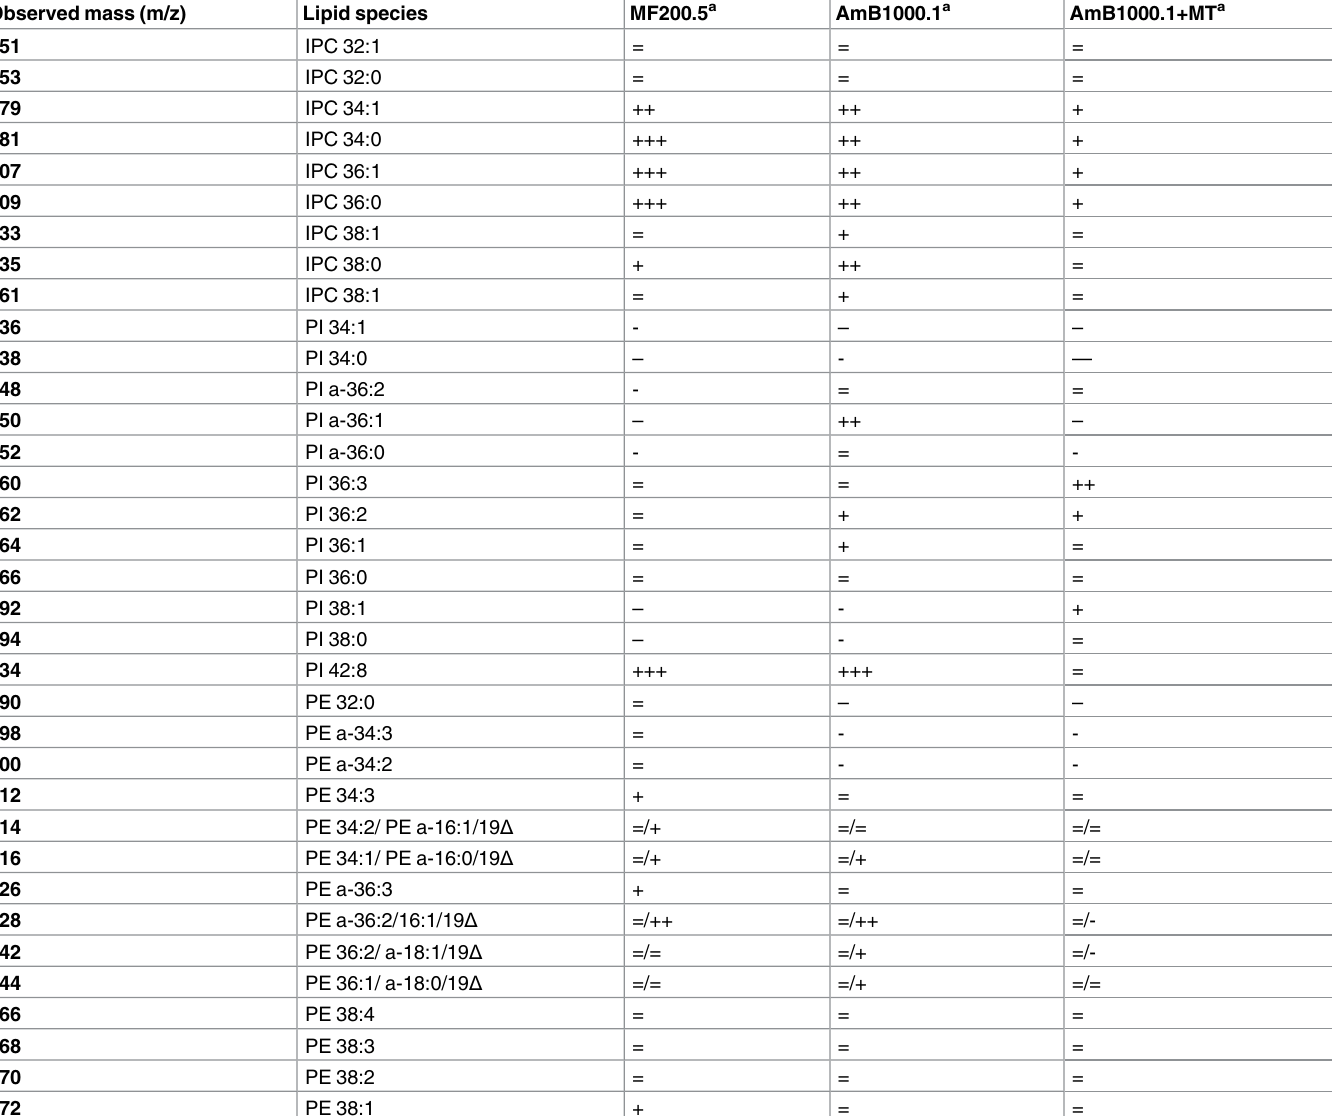
Table 1. Comparison of the lipid PI, IPC and PE species between WT and MF200.5, AmB1000.1or AmB1000.1+MT. These comparisons are based upon parent-ionscanningof m/z 241 for PI and IPC (PI 32:0 was used as an internalstandard); 35-65V and parent-ionscanningof m/z 196 for PE (PE 28:0 was used as an internalstandard). When requiredparent-ionscanningof m/z 295 for C19 Δ andaccurate mass assisted distinctionsbetweenPE species with the same nominalmass (S6 Fig and S3 Table). The symbols show relative increaseor decrease relativeto wild-typecells “+++, ++, +, =, -, –, —”. Observed mass (m/z)